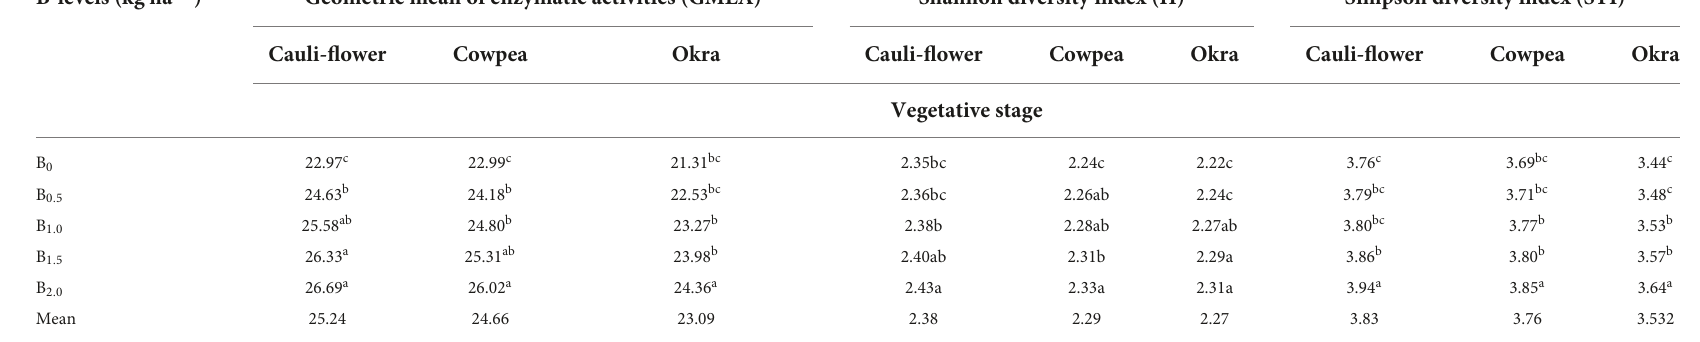
TABLE 6 Geometric mean enzyme activity (GMEA), Shannon diversity index (H) and Simpson diversity index (SYI) as affected by graded B levels under cauliflower-cowpea-okra cropping system (Pooled data